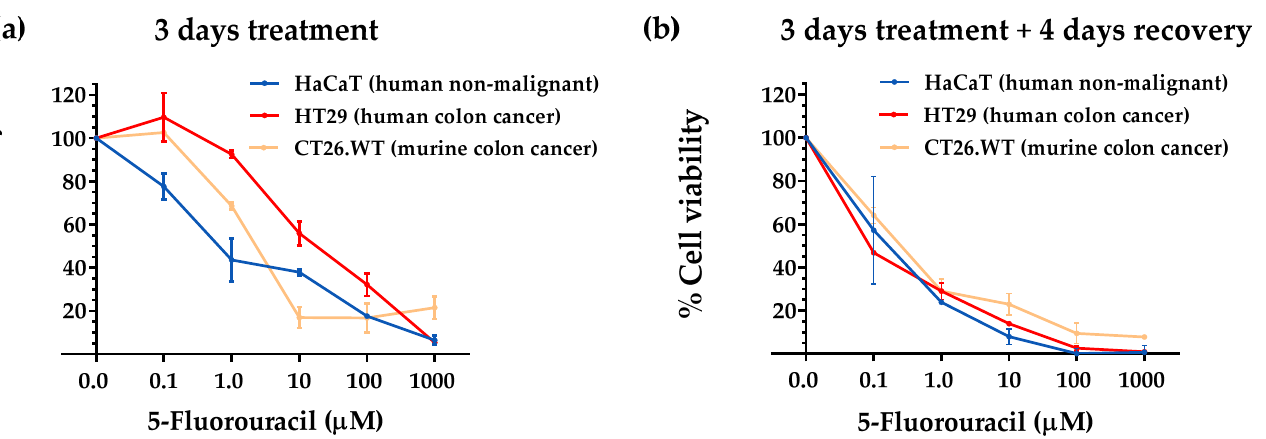
Figure 2. Cell viability of HaCaT, HT29, and CT26.WT cells treated with 5-FU. ( a ) Cell viability after 3 days of 5-FU treatment. ( b ) Cell viability after 3 days of 5-FU treatment followed by 4 days of recovery in DMEM. Cell viability was estimated with an MTT assay. All data are expressed as percentages relative to controls.